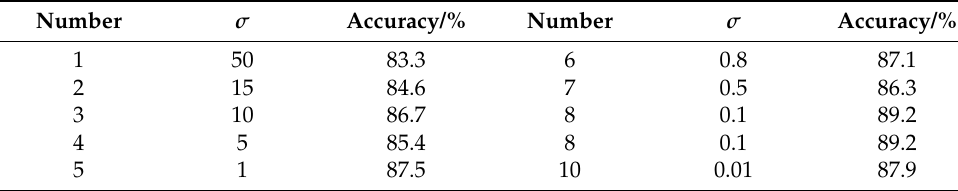
Table 12. GRNN driving propensity identification